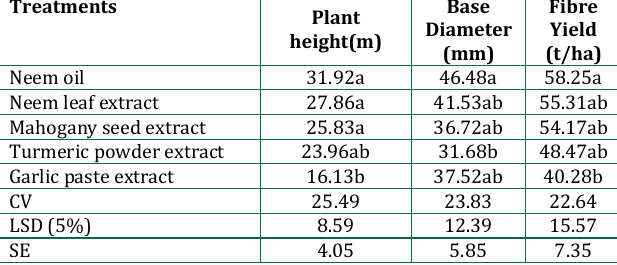
Table 5: Effect of different plant extracts on increase (%) of yield contributing characters of jute over control Treatments